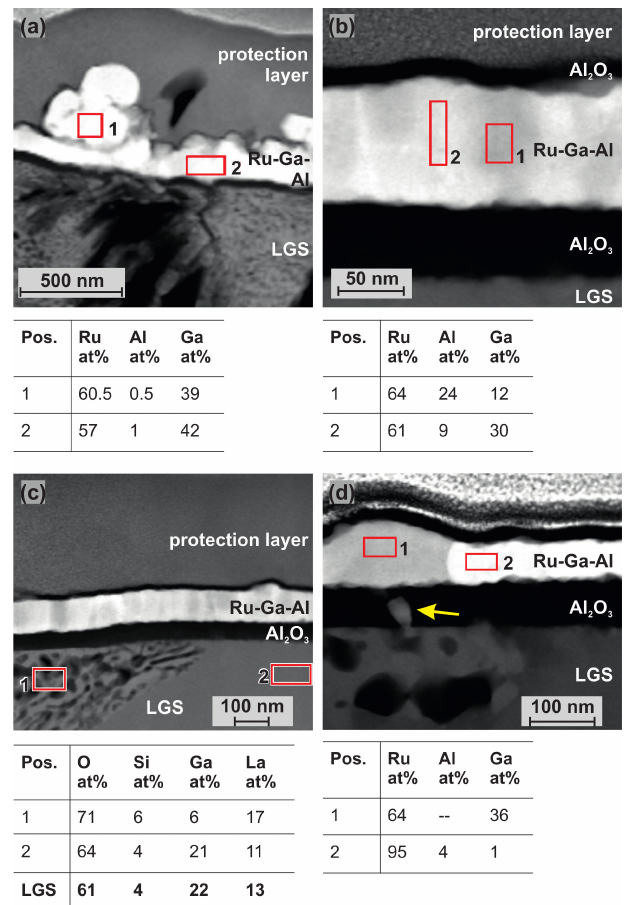
Figure 7. Energy dispersive X-ray spectroscopy (EDX) measurements of the RuAl film deposited on the pretreated substrate after annealing at 800 ◦ C for 10 h. ( a ) at a position at the center of the crack; and ( b ) near to the crack; ( c ) EDX measurement of the LGS substrate in the region of the channels and in an undisturbed region; ( d ) EDX measurement of the RuAl film at a position where the Al 2 O 3 layer is disturbed. The yellow arrow indicates an inhomogeneity within the Al 2 O 3